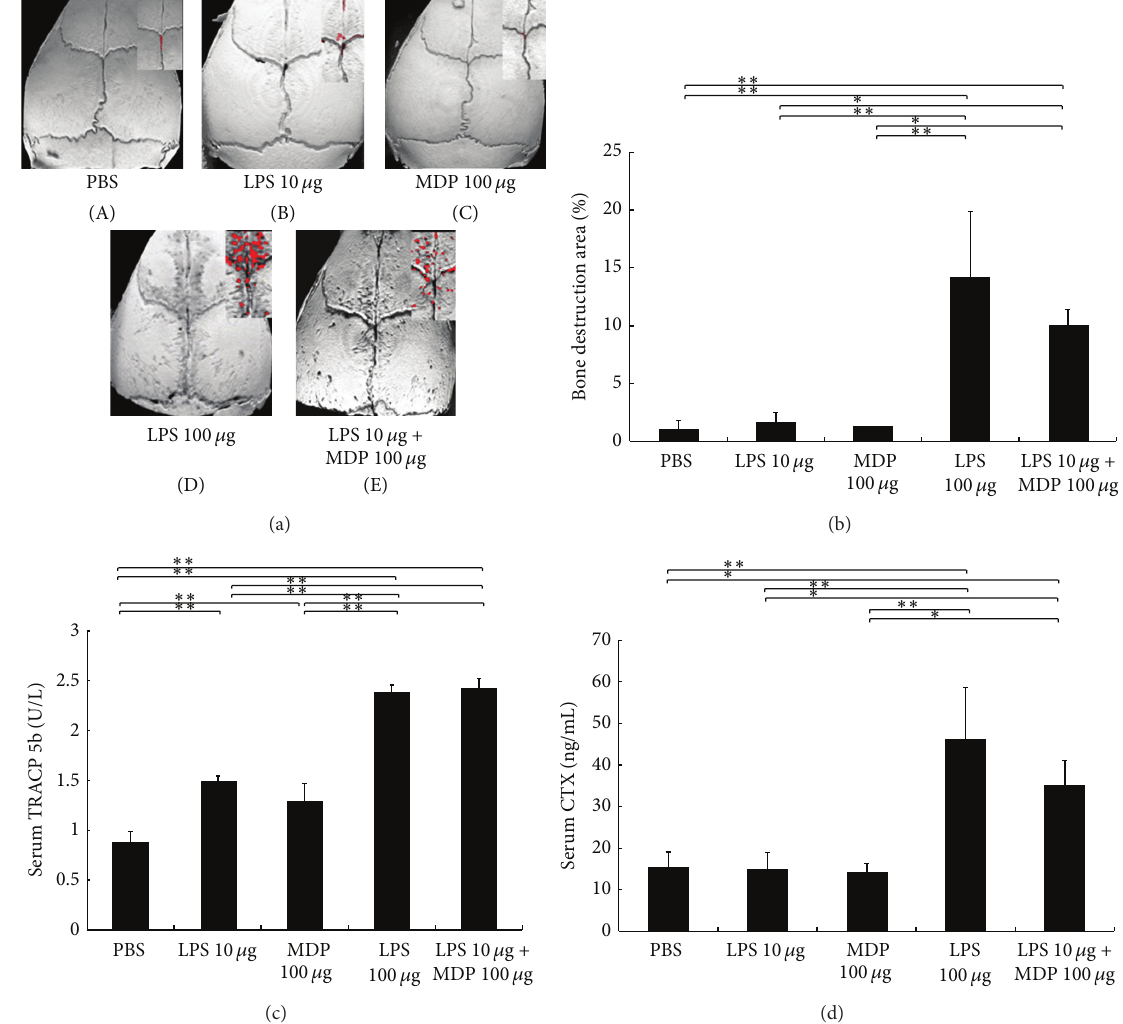
Figure 3: Muramyl dipeptide (MDP) enhances lipopolysaccharide- (LPS-) induced bone destruction in mouse calvariae. (a) Microfocus computed tomography reconstruction images of mouse calvariae harvested after 5 days of daily administration of PBS (A), 10 𝜇 g/day LPS (B), 100 𝜇 g/day MDP (C), 100 𝜇 g/day LPS (D), or 10 𝜇 g/day LPS + 100 𝜇 g/day MDP (E). Red areas indicate larger areas of bone destruction. (b) Ratio of bone destruction area to total area. Results are expressed as the mean ± SD ( 𝑛 = 4 ; ∗∗ 𝑃 < 0.01 ; ∗ 𝑃 < 0.05 ). Differences were determined using Scheffe’s 𝐹 test. (c) Levels of TRACP 5b in mouse serum in vivo . Serum was obtained from mice after five days of daily administration into the calvariae. Circulating levels of tartrate-resistant acid phosphatase (TRACP 5b) were determined by enzyme-linked immunosorbent assay (ELISA). Results are expressed as the mean ± SD ( 𝑛 = 4 ; ∗∗ 𝑃 < 0.01 ). (d) Levels of C-terminal telopeptide fragments of type I collagen in mouse serum in vivo . Circulating levels of C-terminal telopeptide fragments of type I collagen were determined by Mouse CTX Assay kit. Results are expressed as the mean ± SD ( 𝑛 = 4 ; ∗∗ 𝑃 < 0.01 ; ∗ 𝑃 < 0.05 ). Differences were determined using Scheffe’s 𝐹